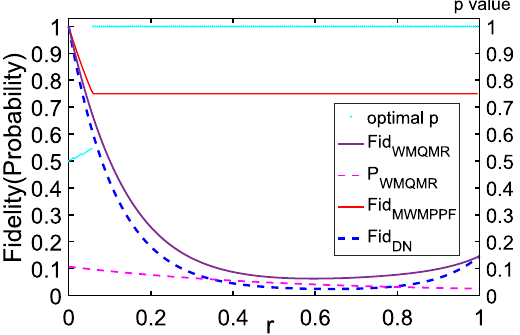
Figure 6. Average fidelity and probability and the optimal p value vs. r with θ = 3 π /4. (1) Fid DN (blue dashed line); (2) Fid MWMPPF (red full line) under its optimal p value evolves with r ; (3) the optimal p value of average fidelity (celeste dotted line) evolves with r ; (4) Fid WMQMR (purple full line) with its p 1 = p r = 0.2 and its probability is: (5) P WMQMR (magenta dashed line) with the same